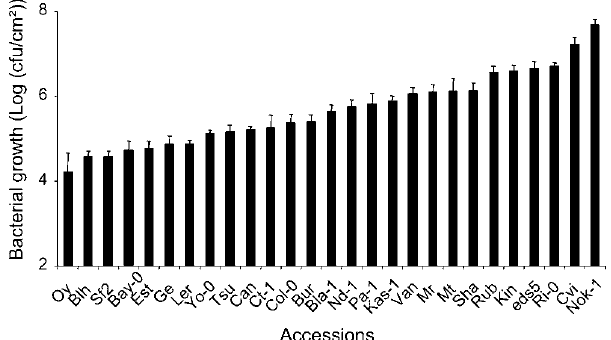
Figure 1. Natural variation of partial resistance to Pseudomonas syringae pv. tomato DC3000 among Arabidopsis accessions. In planta bacterial growth was assessed three days post inoculation with a bacterial suspension adjusted to 10 5 cfu/mL. Means and standard errors were calculated from bacterial densities in at least 4 plants.